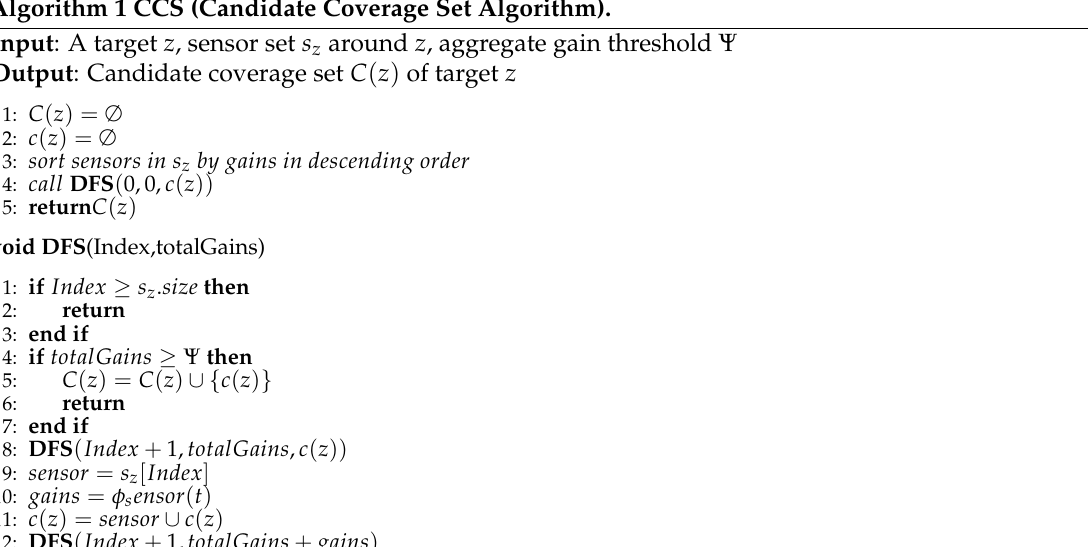
Algorithm 1 CCS (Candidate Coverage Set